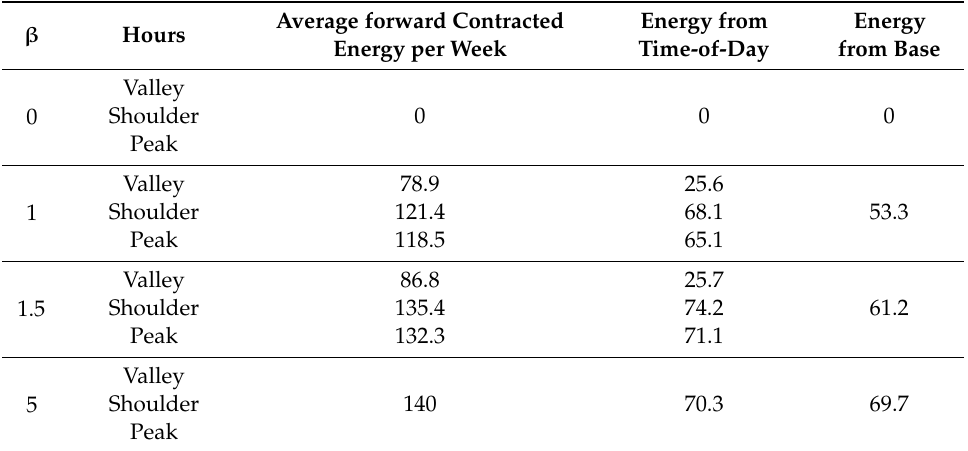
Table 8. Forward contract: valley, shoulder and peak hour statistics